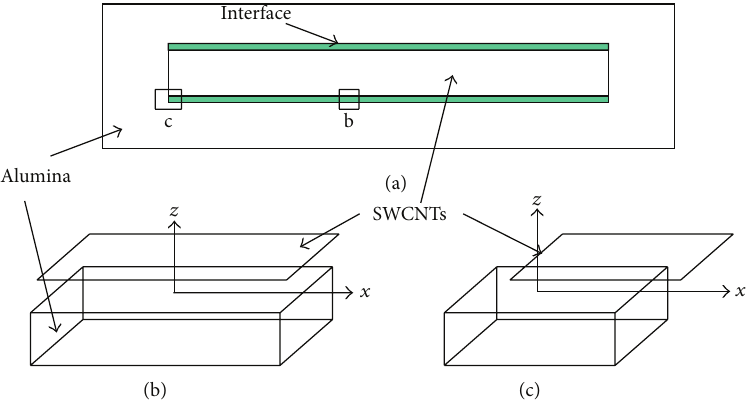
Figure 2: SWCNT-alumina composites. (a) Representative volume element, (b) nonboundary interface, and (c) boundary interface.